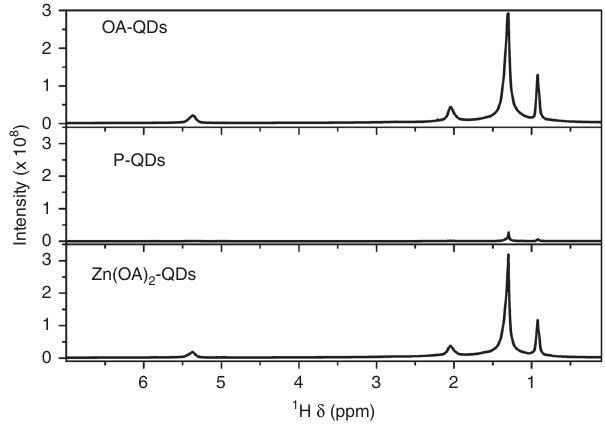
Fig. 2 Nuclear Magenetic Resonance Measurements. Nuclear magnetic resonance ( 1 HNMR) spectra of different